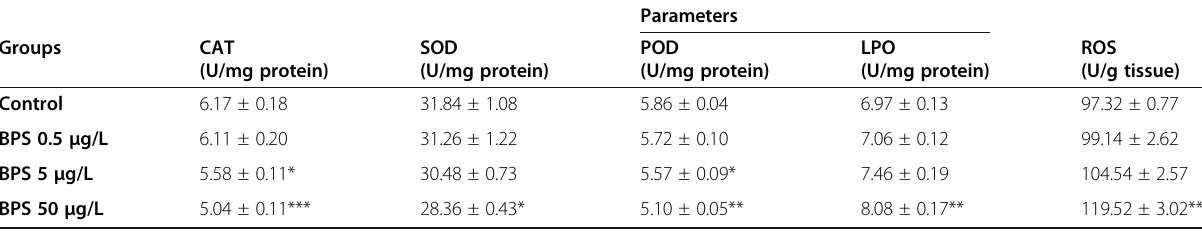
Table 2 Effect of chronic exposure of different concentrations of BPS (0.5 μ g/L, 5 μ g/L, and 50 μ g/L) on oxidative stress in the testicular tissues of male rats